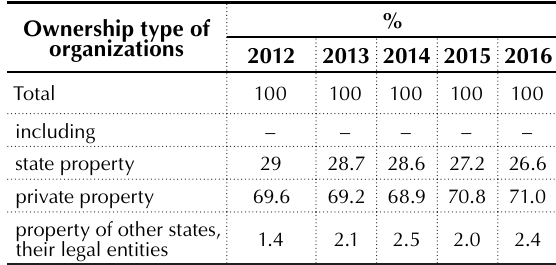
Table 4. Number of organizations engaged in R&D, by ownership type